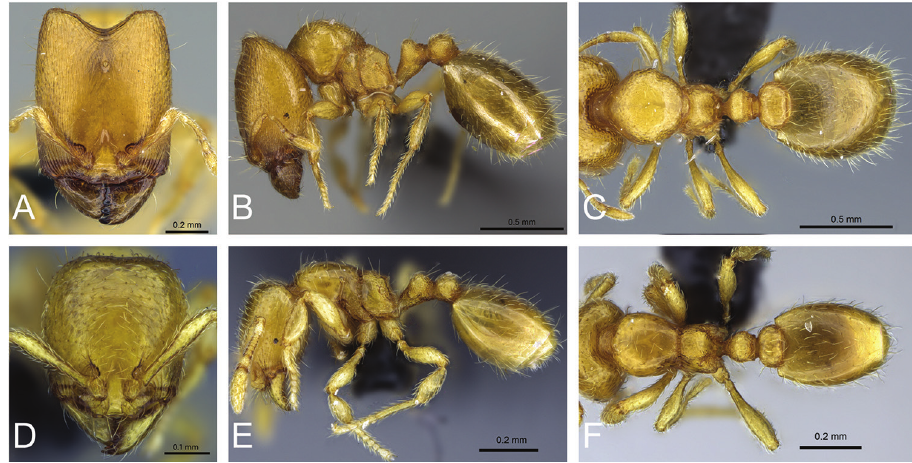
Figure 62. Carebara sampi –holotype. Major worker, CASENT0031265: A head in full-face view B body in profile view C body in dorsal view. Minor worker, CASENT0031214: D head in full-face view E body in profile view F body in dorsal